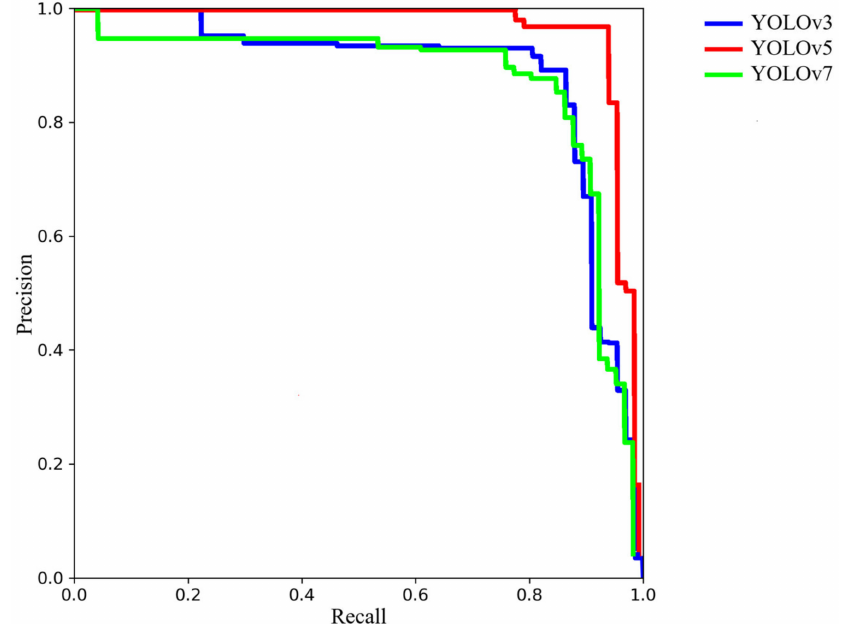
Figure 16. Precision-recall